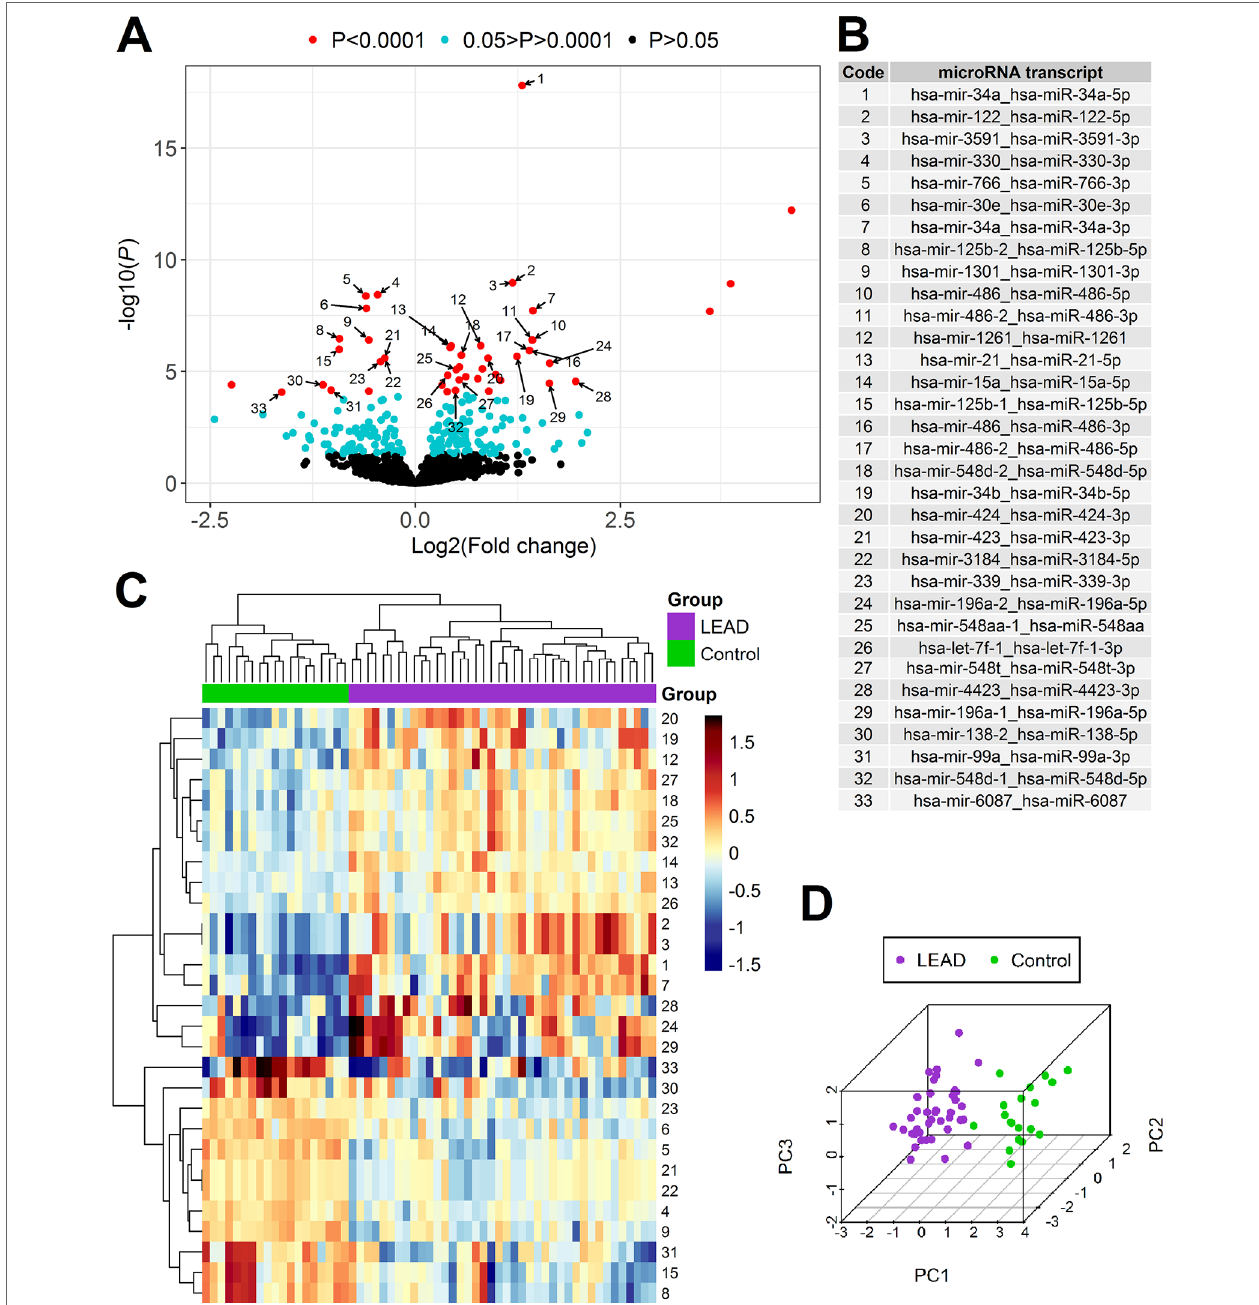
FigURE 2 | Differential expression analysis of miRNA in PBMCs samples derived from 40 patients with LEAD (LEAD) and 19 non-LEAD controls (Control). Volcano plot (A) illustrating the arrangement of negative log10 of P values and log2 fold changes for 1,181 differentially expressed miRNA transcripts indicated using DESeq2 method. Thirty-three miRNA transcripts resulted from DESeq2 method with P < 0.0001 overlapping with informative miRNAs returned from UVE-PLS analysis were pointed with numbers corresponding to the code and names in table on panel (B) . Heatmap with Euclidean clustering (c) and 3D PCA plot (D) , generated based on expression of selected 29 miRNA transcripts (after excluding four miRNA transcripts belonging to miR-486 family). Numbers of heatmap rows correspond to transcript names according to “Code” column on panel (B) .